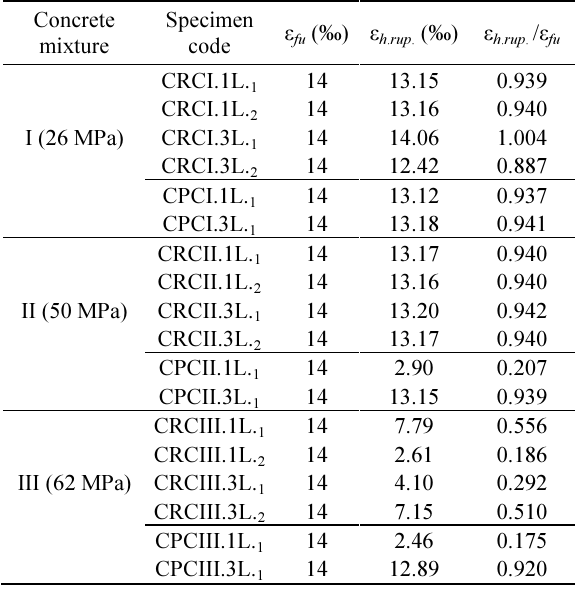
Table 4. Average hoop rupture strain ratios (circular specimens)